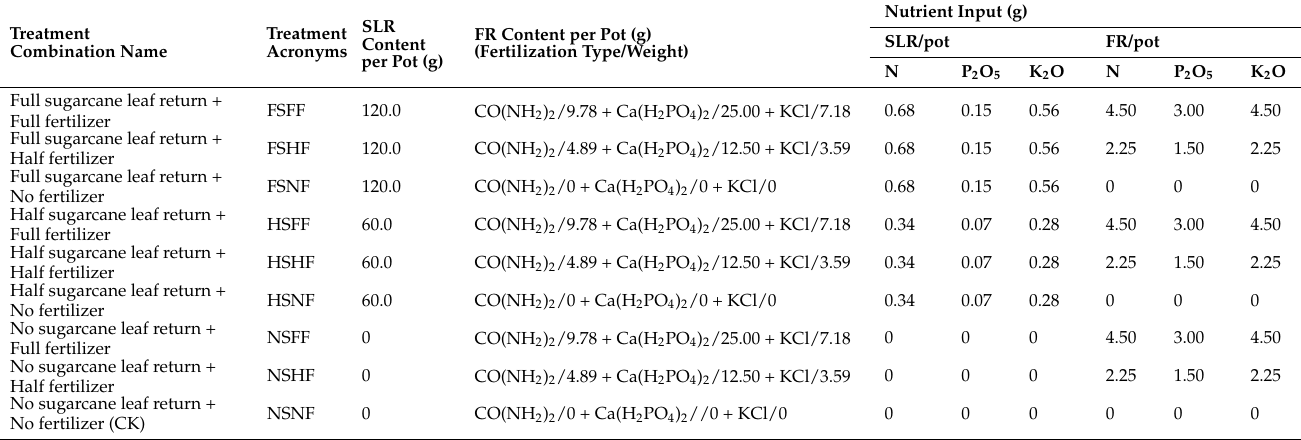
Table 4. Experimental design and nutrient input of experimental